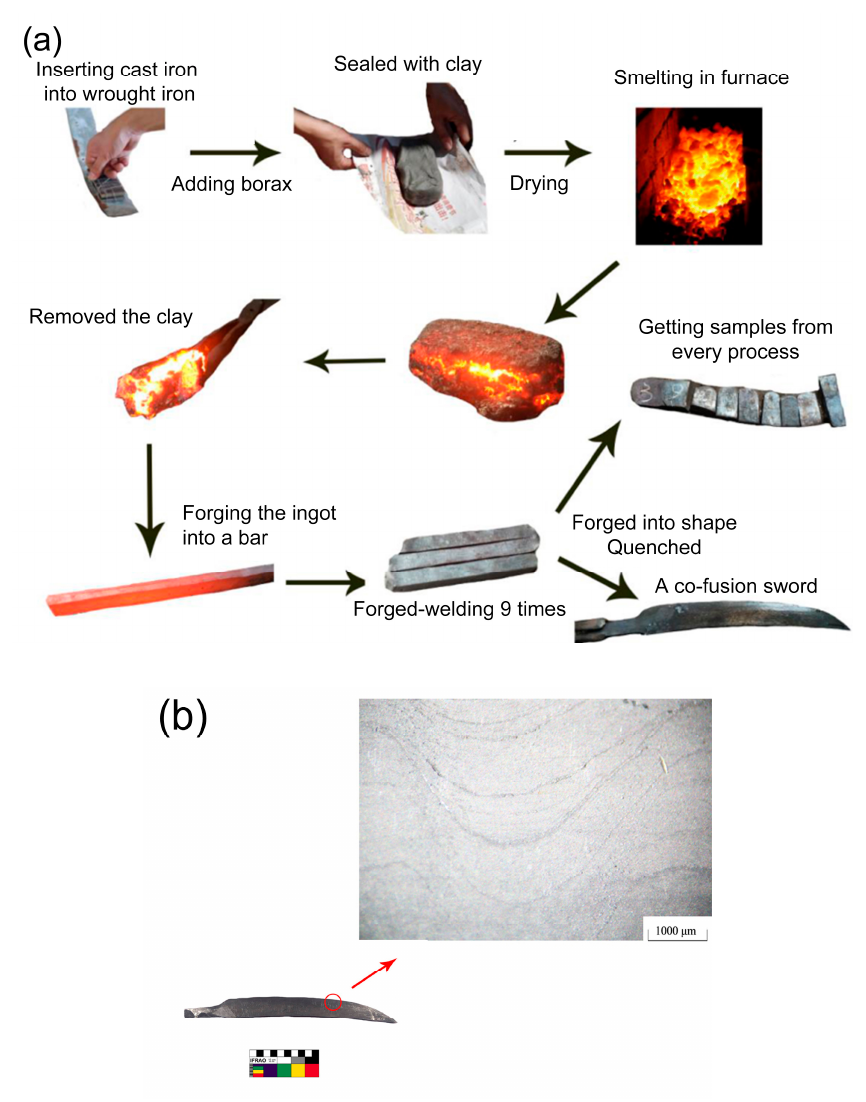
Figure 3. Inserting cast iron into wrought iron to make swords: ( a ) technological process; ( b ) the sword and pattern on the surface.